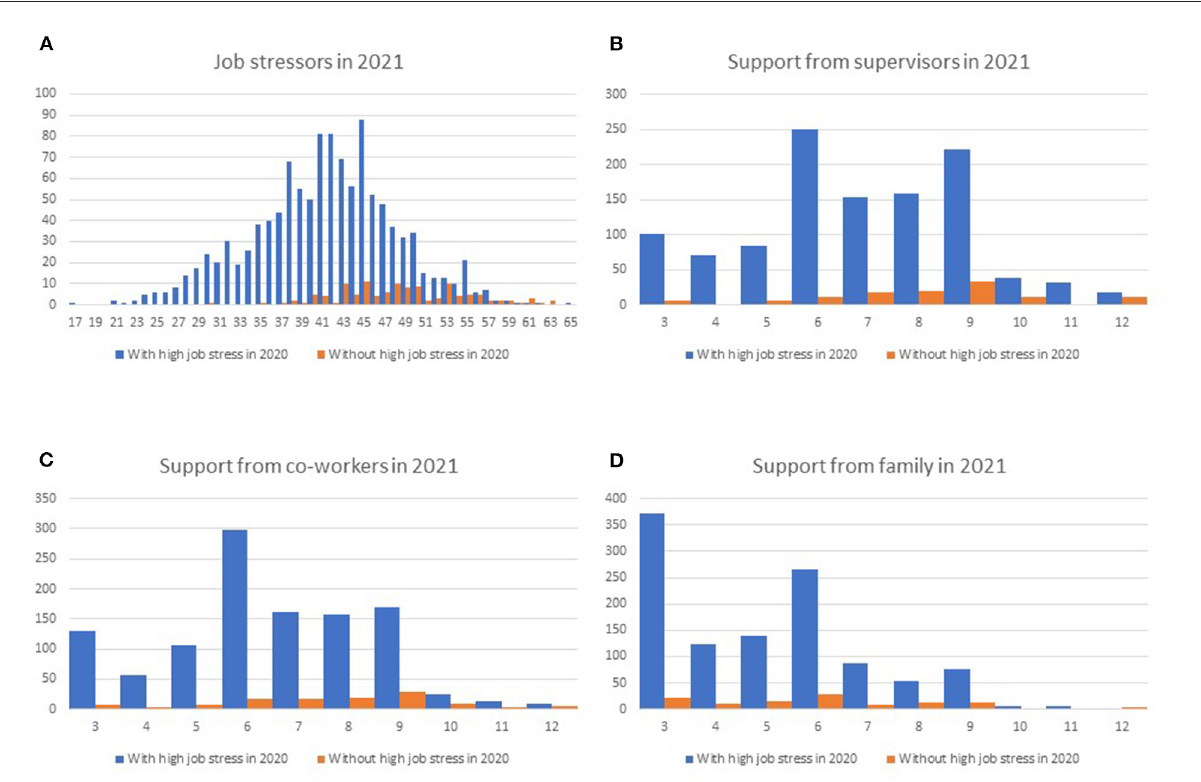
FIGURE2 Histogram of stressors and support scores in 2021, classified according to the presence (orange) or absence (blue) of high stress levels in 2020. Job stressors (A) and support from supervisors (B) , co–workers (C) , and family (D) are presented. A smaller number of job stressors suggests less job stress. Smaller scores in the responses to the questions about support suggest a better support